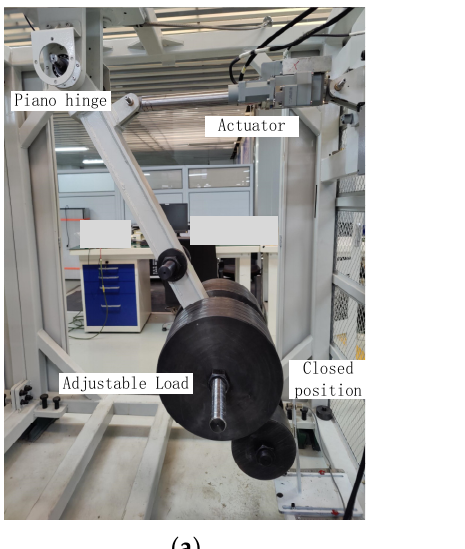
Figure 10. Block diagram of the − 50 ◦ C experiment.